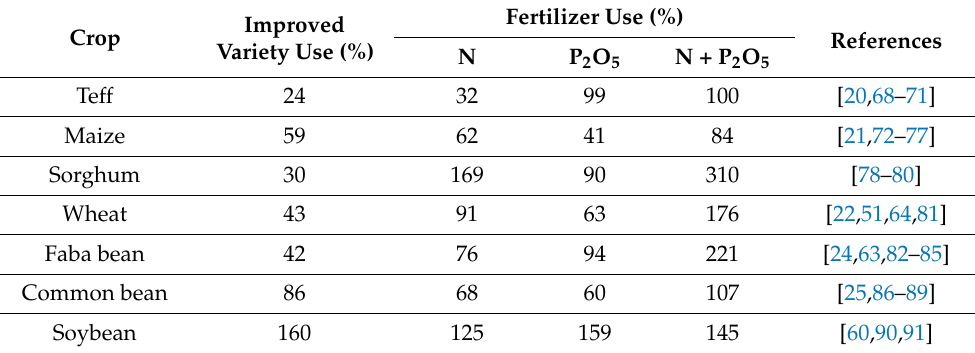
Table 3. Yield increases due to the use of improved variety seeds and proper fertilization of the cropping